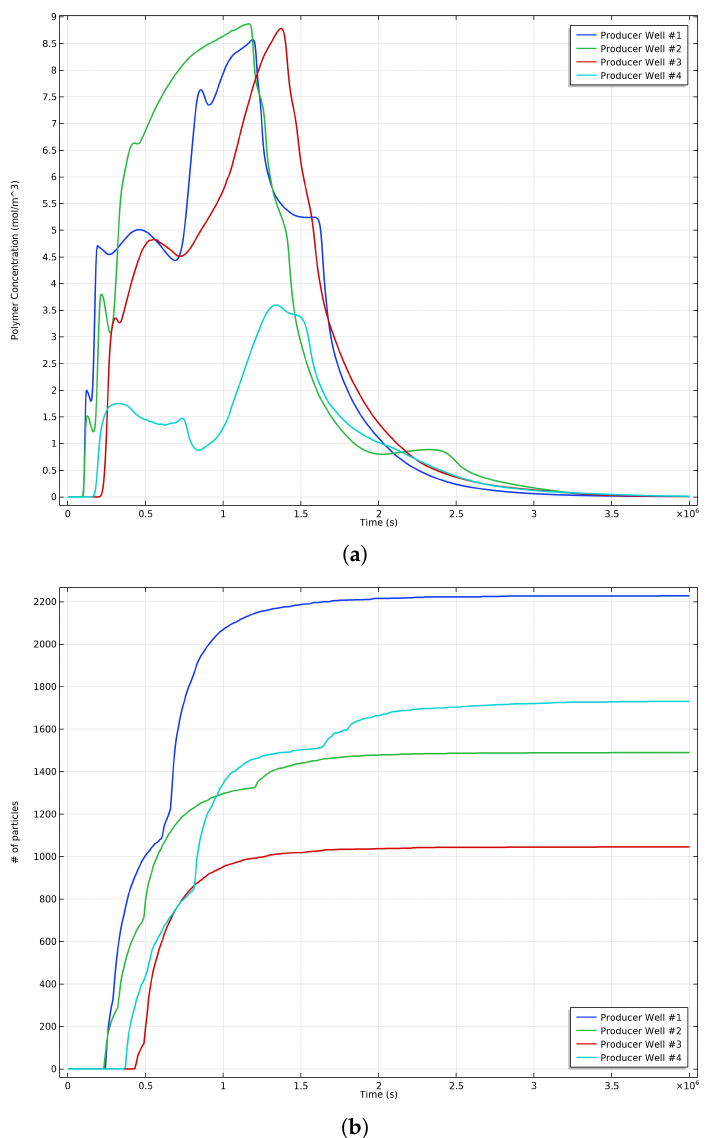
Figure 21. Polymer concentration ( a ) and number of particles ( b ) at the producer wells as a function of